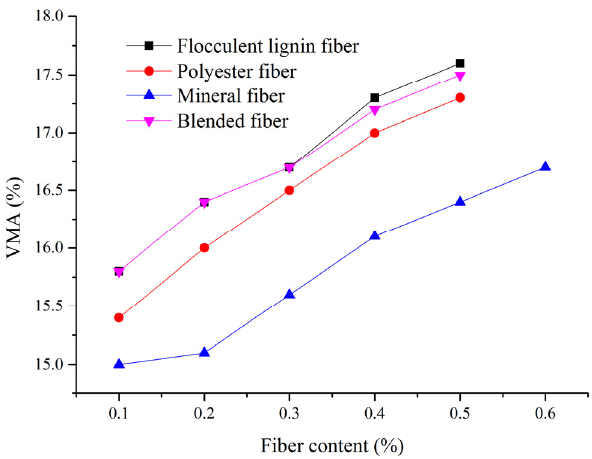
Figure 5. VMA of SMA specimens with four different fiber types.